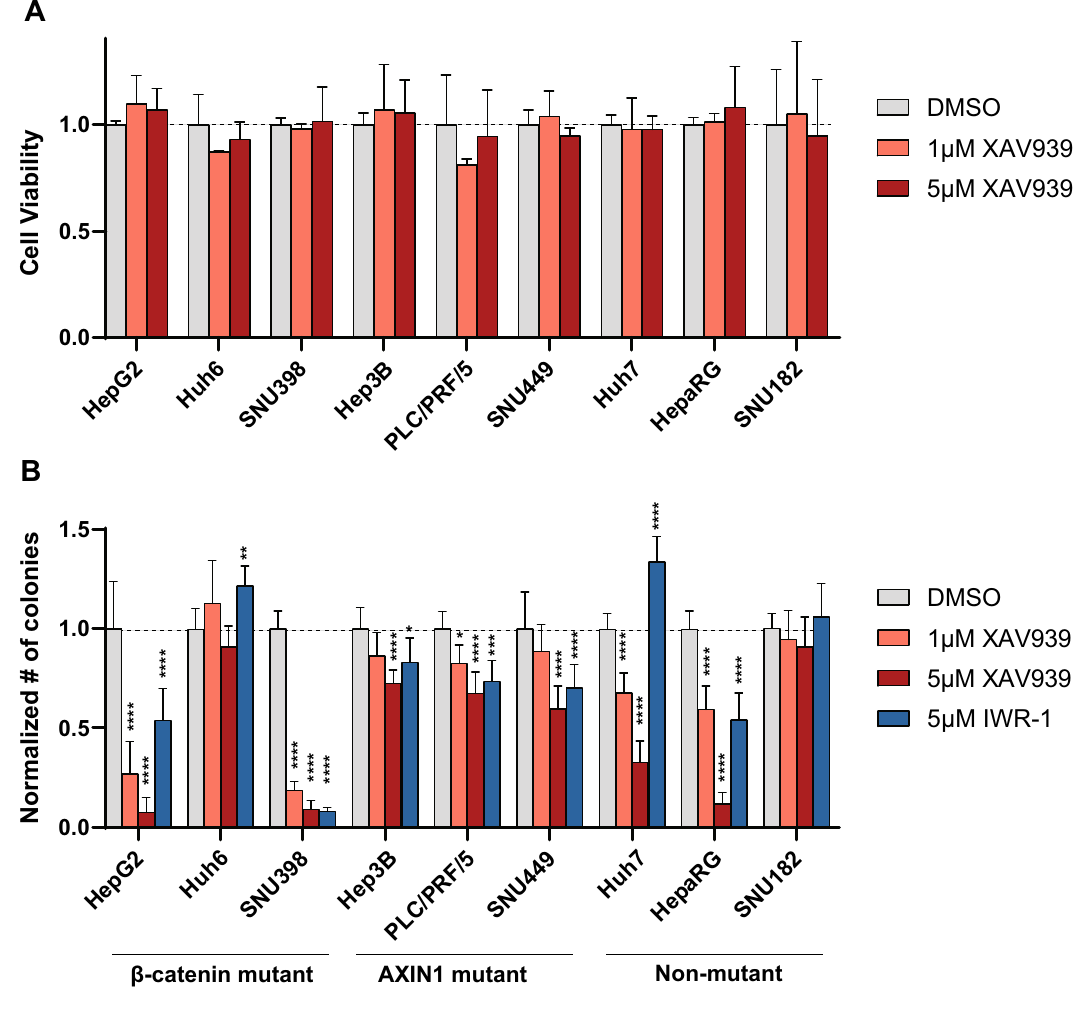
Figure 5. Effect of tankyrase inhibitor XAV939 on the viability and colony formation capacity of HCC lines. ( A ) HCC cell lines were treated with XAV939 at 1 μM or 5 μM for three days followed by a MTT-assay (n = 4). No statistical significant growth reduction was observed (unpaired t-test). ( B ) Fold changes observed in a colony formation assay following XAV939/IWR-1 treatment. Only significant changes are shown (mean ± SD, n = 6, *P < 0.05; **P < 0.01; ***P < 0.001; ****P < 0.0001; unpaired t-test).